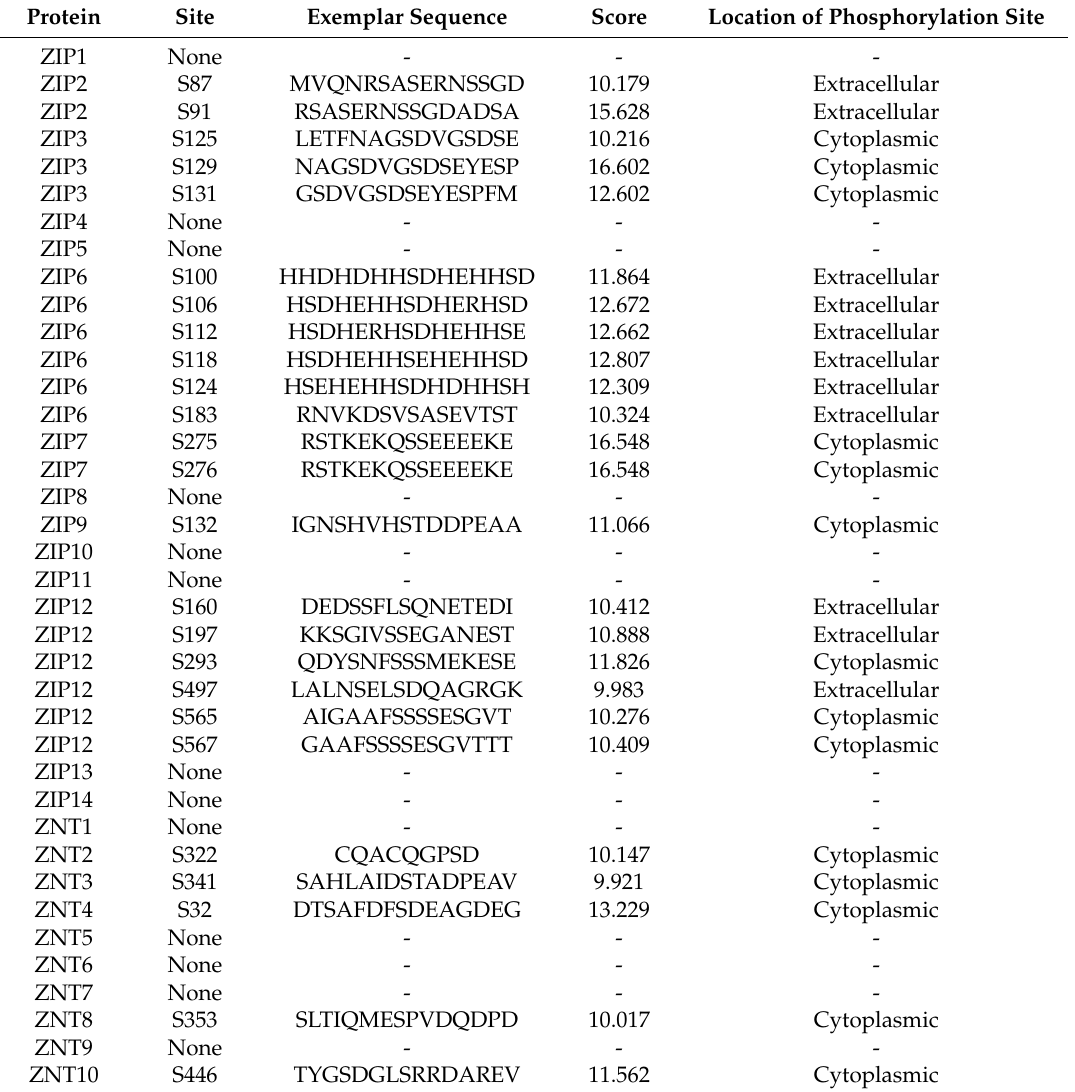
Table 1. Phosphorylated sites predicted in the zinc